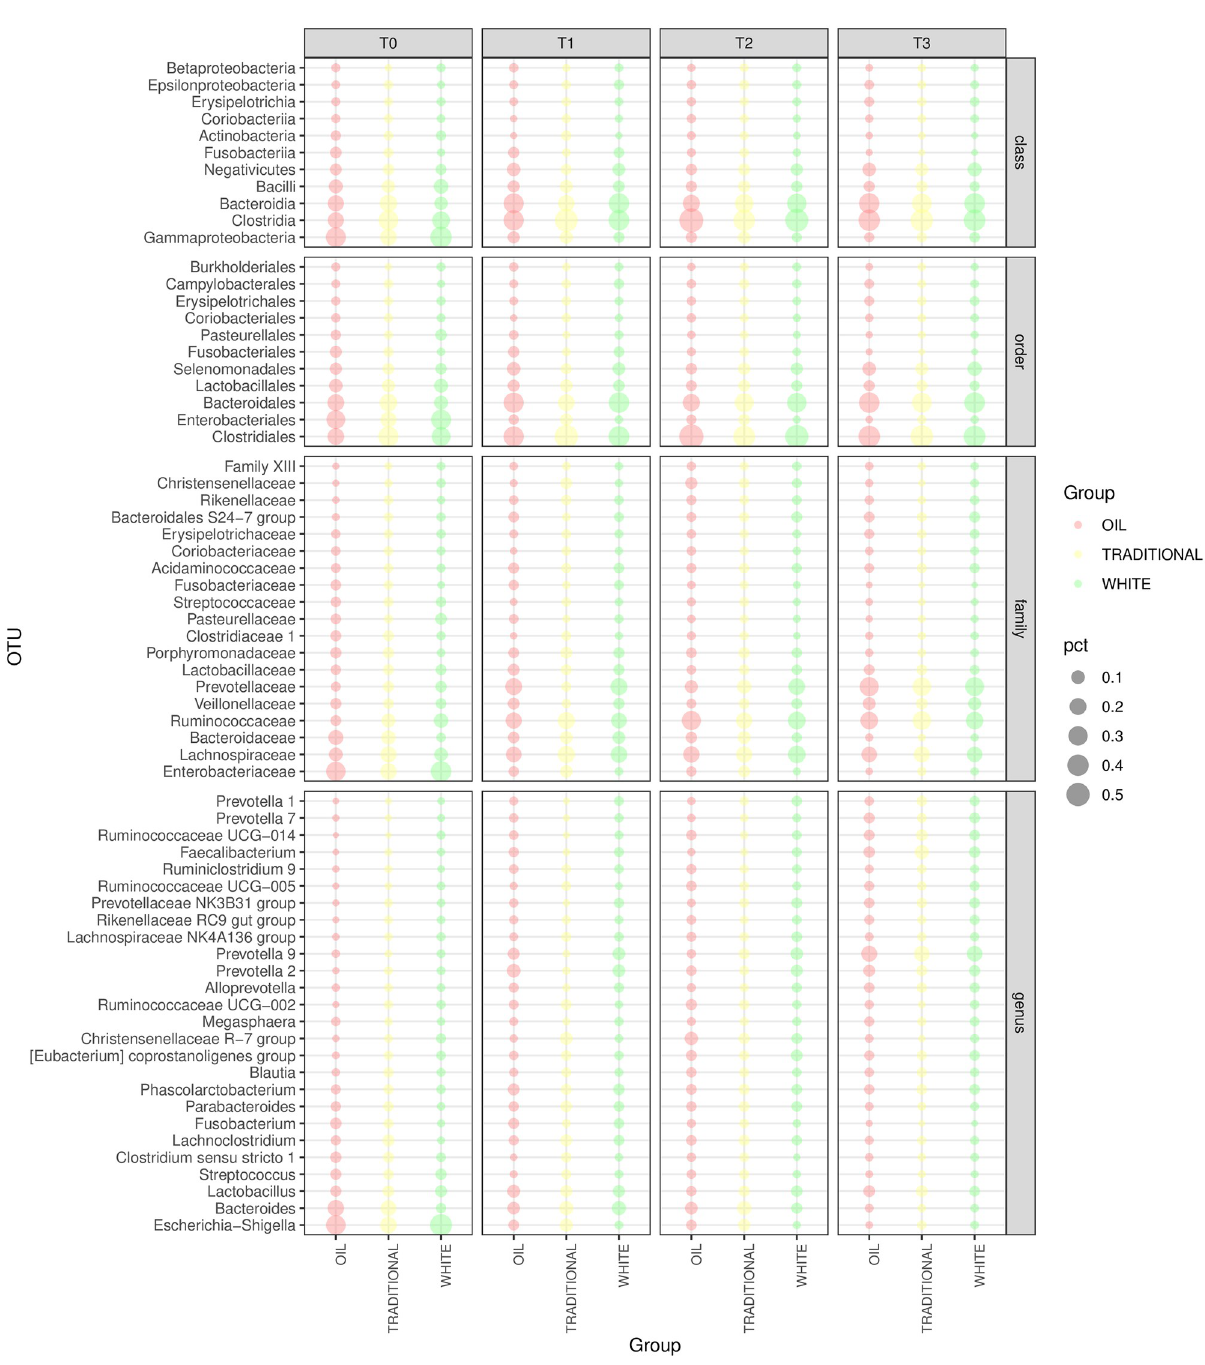
Fig 2. Relative distribution of taxonomic levels. Relative abundance of classes, orders, families and genera in the piglet gut microbiota between treatments (traditional diet, white diet, oil diet) and over time; only taxa with relative abundance > 0.001 are shown. post-weaning), and by treatment before and after weaning (day 26). From PERMANOVA (999 permutations), the between-treatment p-value was 0.052, the p-value for the difference before and after weaning was 0.001, and the treatment-by-timepoint interaction had a p- value = 0.0086.